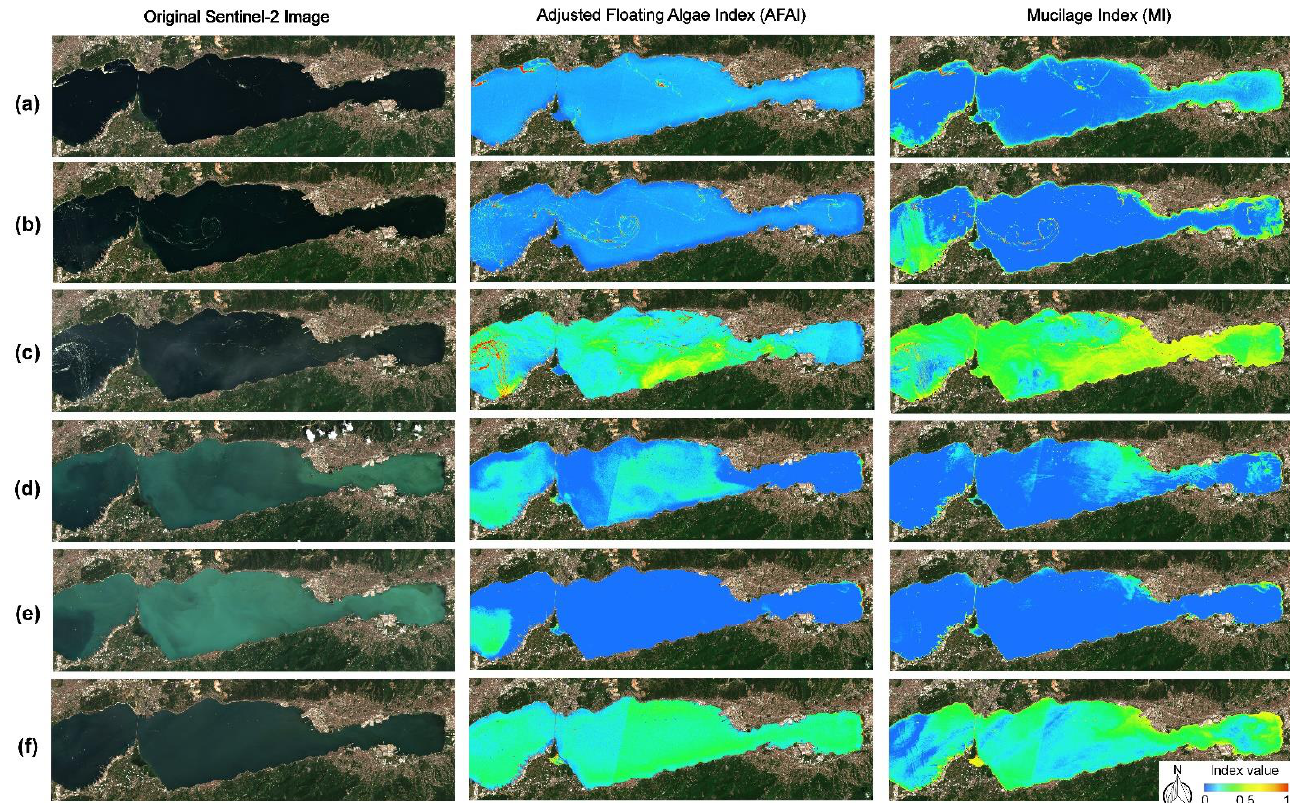
Figure 3. Estimated thematic maps of AFAI and MI from Sentinel-2 images acquired on ( a )